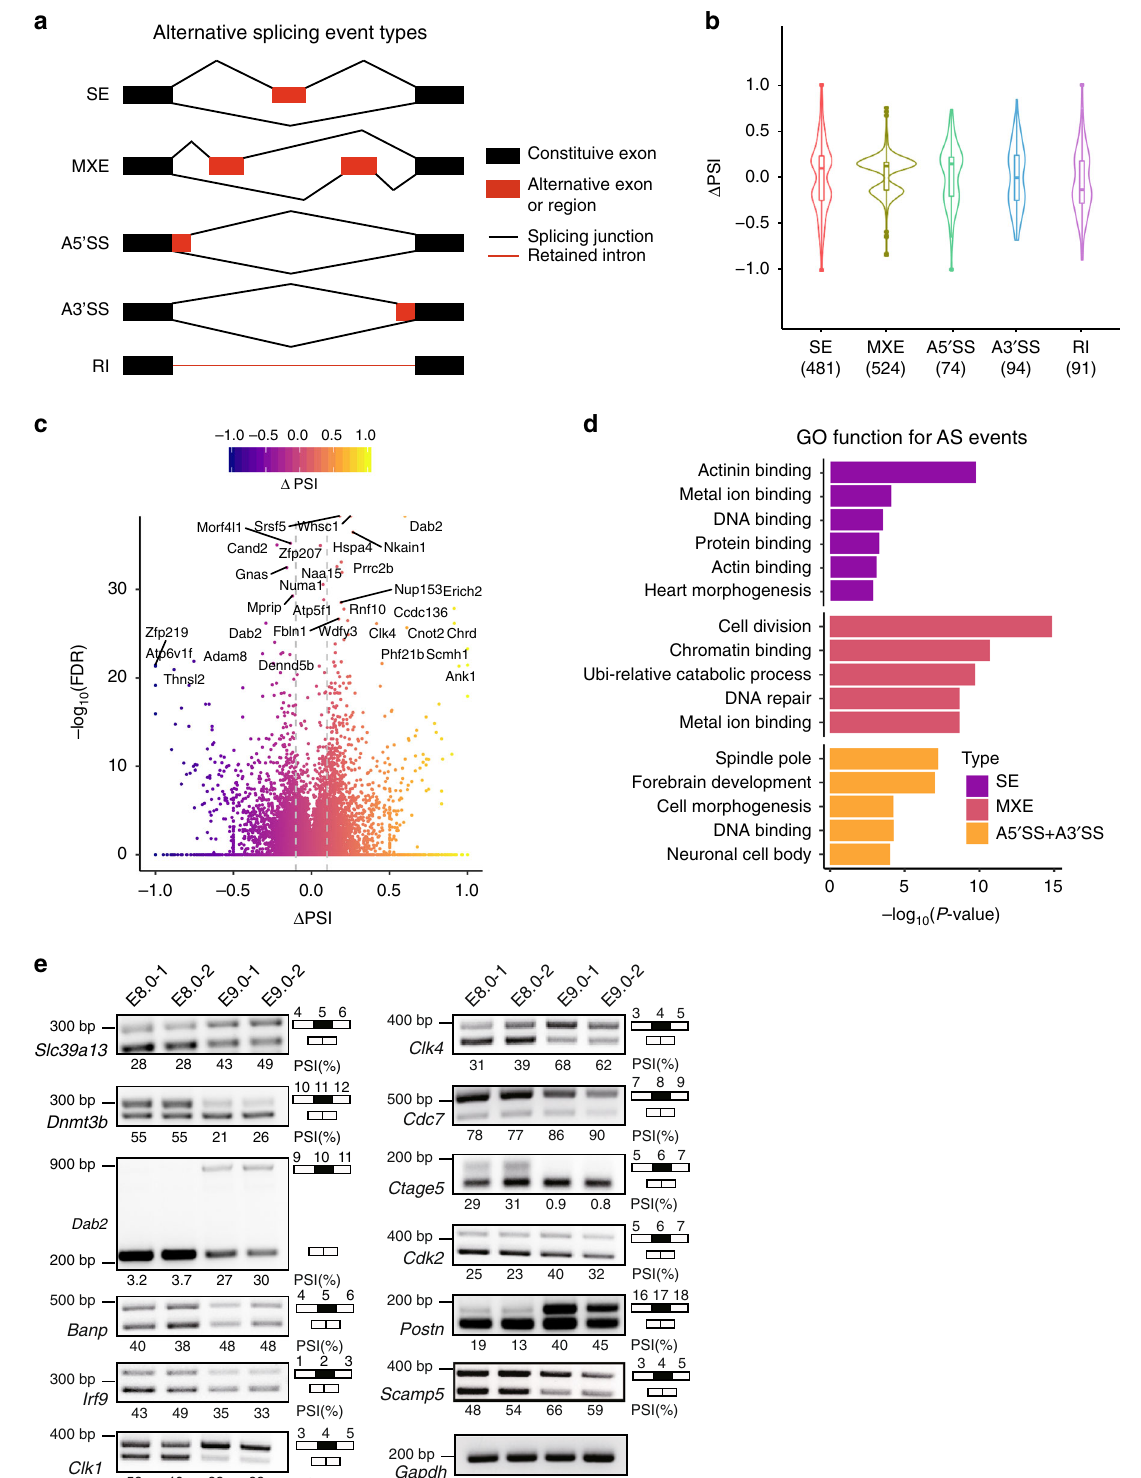
STRAP interacts with components of spliceosomal machinery . STRAP is linked to the cytosolic and nuclear SMN complex 15,28 , but its other functions in the nucleus have not been elucidated. To determine this, we performed co-immunoprecipitation (co-IP) experiments with antibodies against STRAP and IgG using nuclear extracts (NEs) from mouse ESCs (Supplementary Fig. 3a). Co-IP samples were then visualized on SDS-PAGE and identi fi ed by LC-